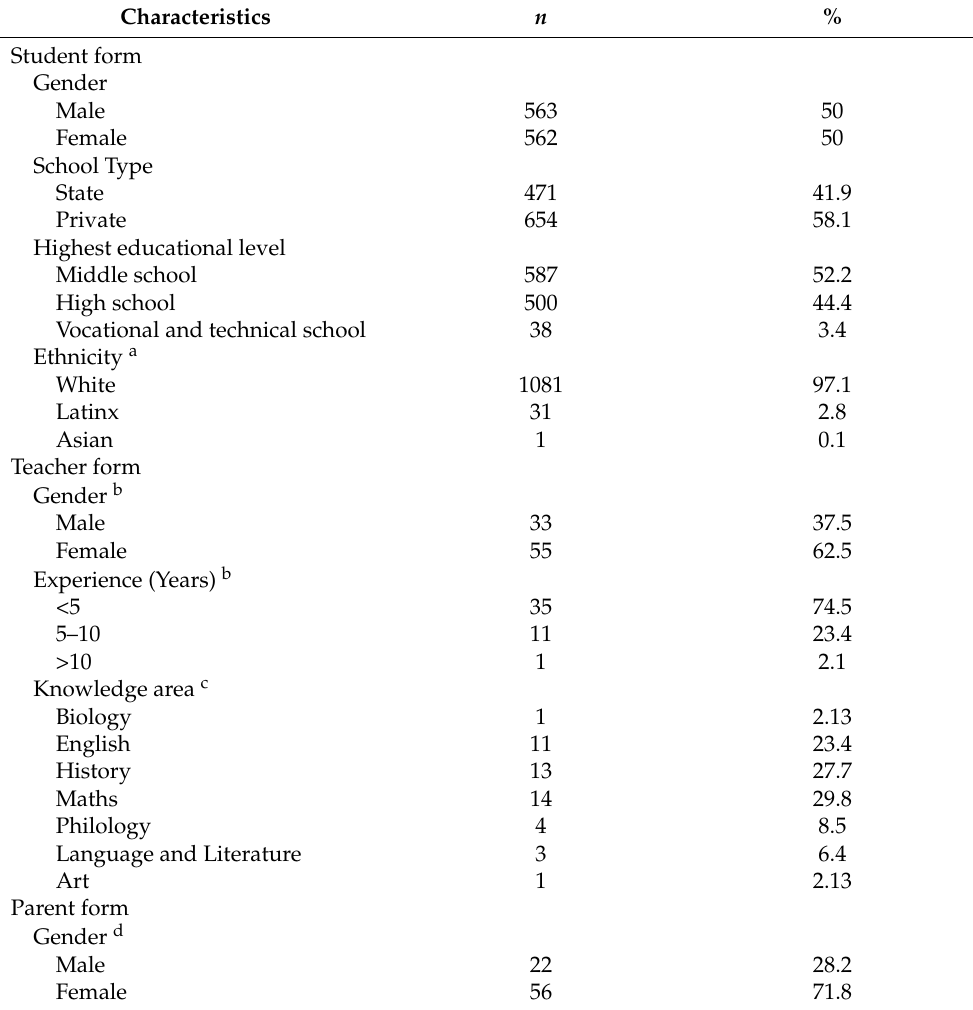
Table 1. Demographic